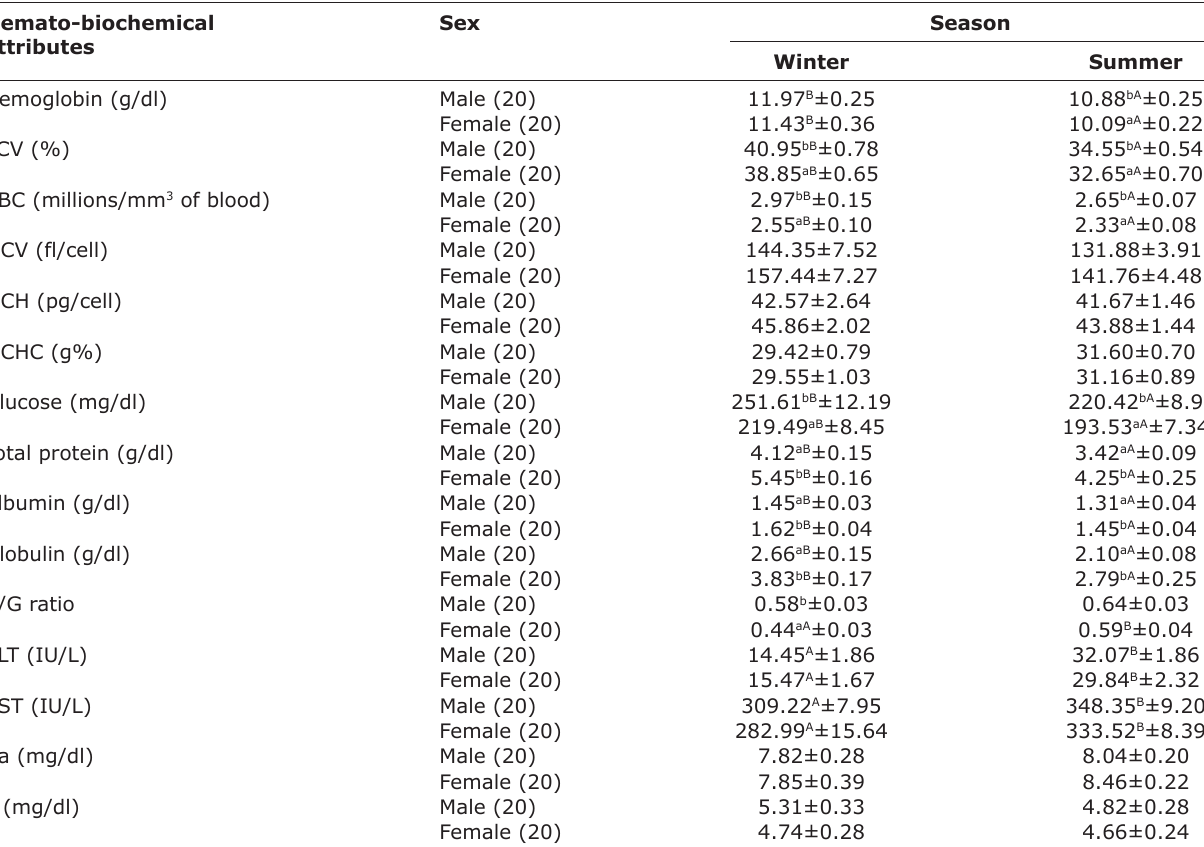
Table-1: Effect of season and sex on hemato-biochemical profile in Turkey (mean±SE). Hemato-biochemical